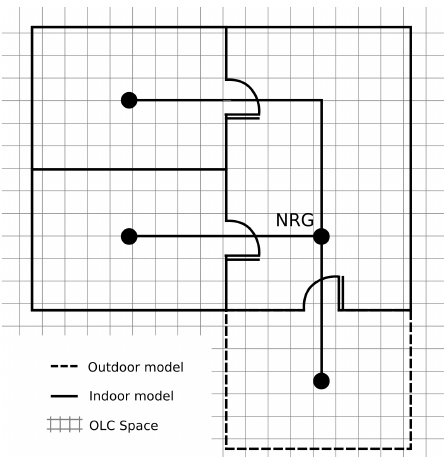
Figure 6. Process for the integration of indoor models in the outdoor model. NRG: node-relation